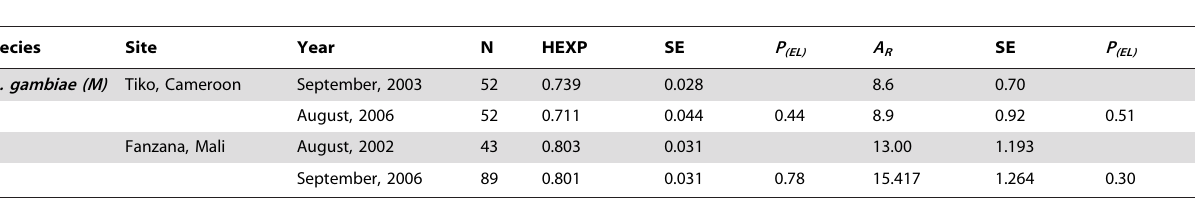
Table 3. Summary of heterozygosity estimates ( H E ) and Allelic Richness ( A R ) for the two negative control populations—each with two time points, and standard errors